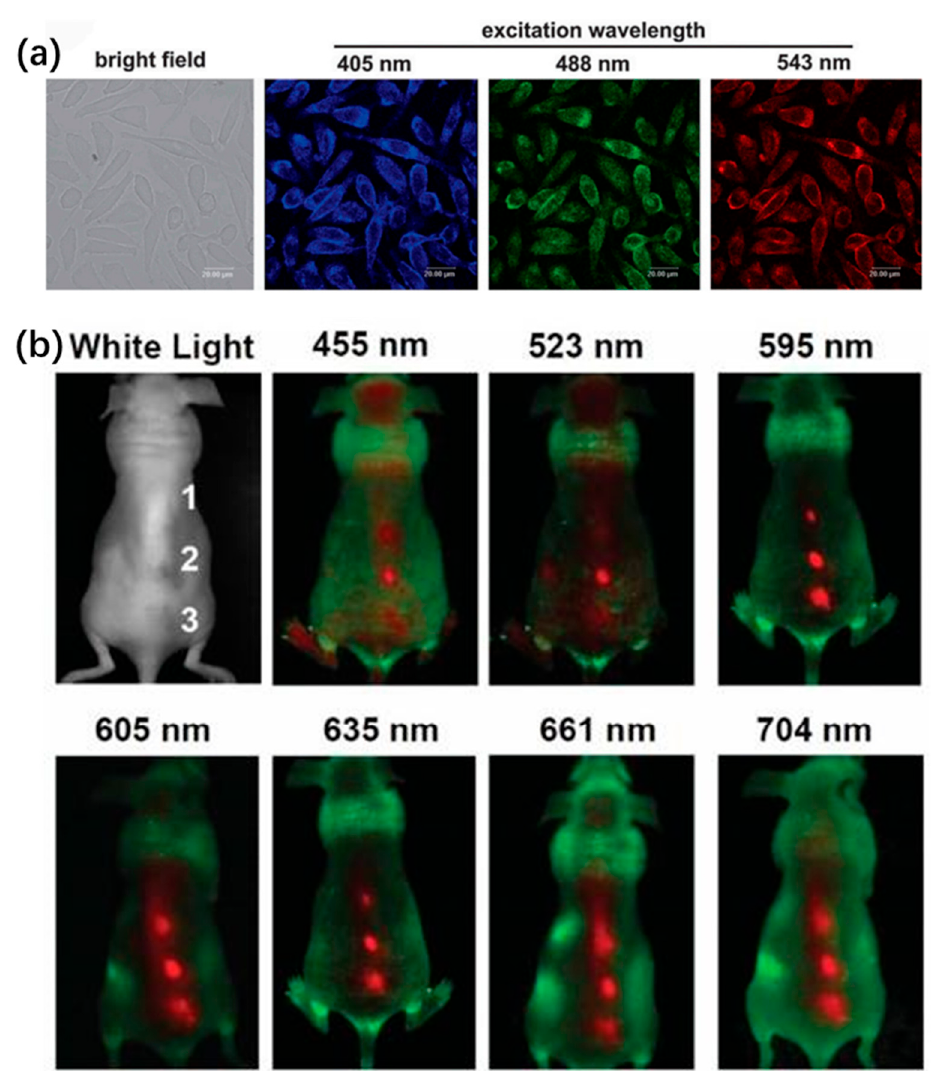
Figure 21. ( a ) The in vivo images of L929 cells which are injected with CDs under different excitation wavelengths [163]. Copyright 2012, Royal Society of Chemistry. ( b ) The in vivo fluorescence images of CDs that are injected into a nude mouse [164]. Copyright 2011, John Wiley and